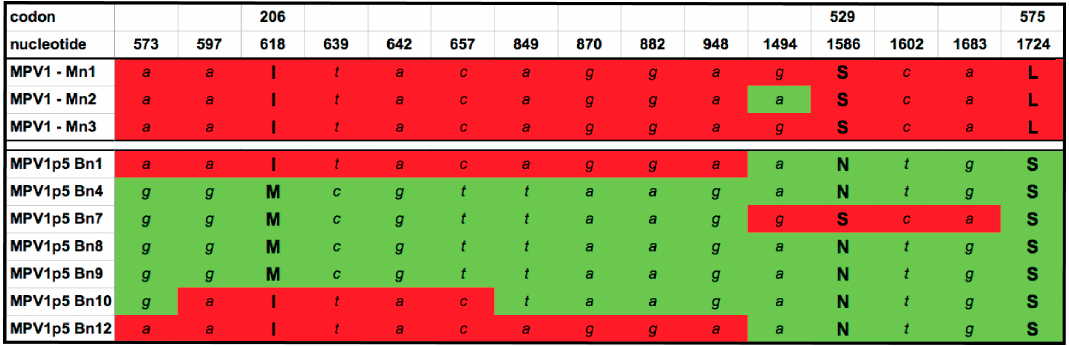
Figure 3. Analysis of mutations found in the NS / VP1 region. Three clones from the starter MPV1 pool and seven clones from MPV1p5 were sequenced and compared to one another. Both synonymous and non-synonymous mutations found in more than one PCR clone are included. As before, clones are named for the originating virus stock, “M” for parental and “B” for B16F10-passaged virus, and “n” for the NS / VP1 region, followed by the sample number. NS2 and VP1 SR protein sequences were identical between all MPV1 and MPV1p5 clones. Red and green shading denote sequences conforming to the predominant sequences of the MPV1 parental and MPV1p5 NS/VP1 clones, respectively.